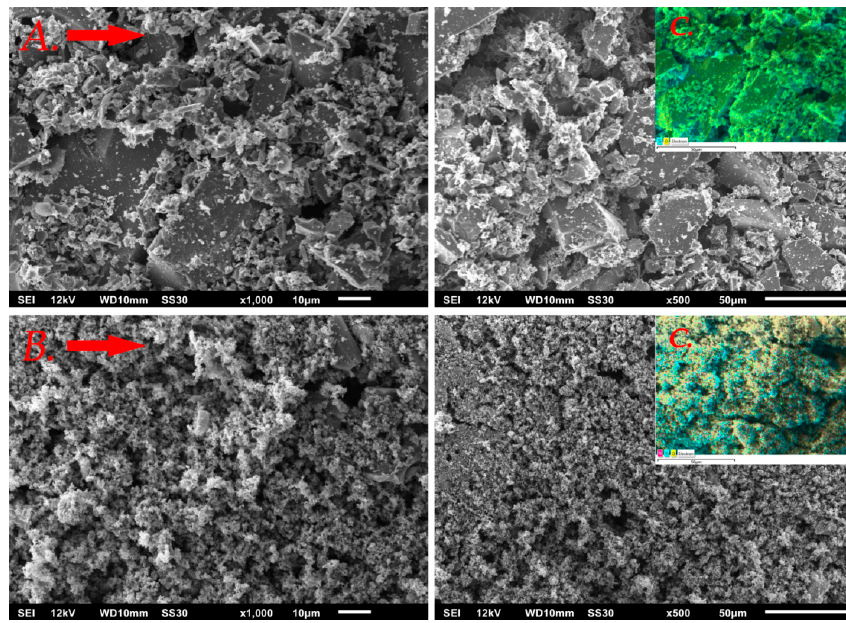
Figure 4. SEM pictures of TiO 2 ( A ) and 5N_TiO 2 ( B ) and EDS elements mapping ( C ).